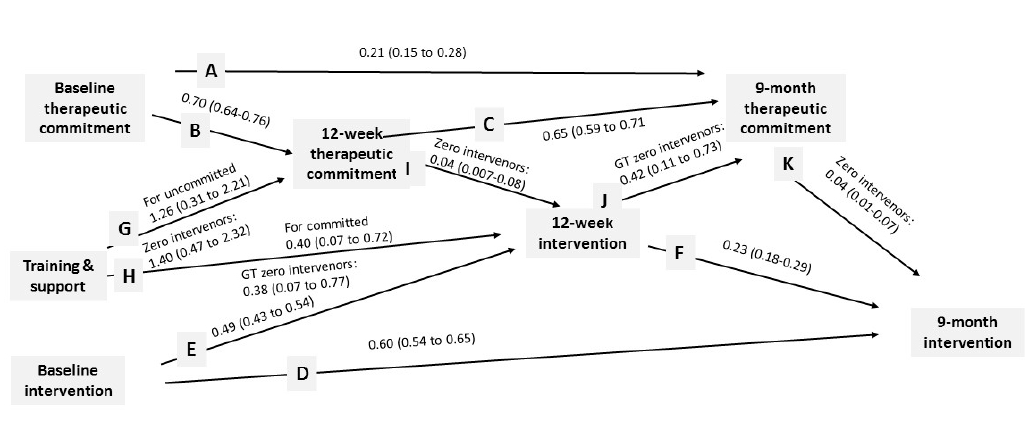
Figure 4. Unstandardized estimates (95% confidence intervals) for interrelationships between therapeutic commitment and proportion of patients intervened (estimates for impact of training and support have been doubled—see statistical methods).